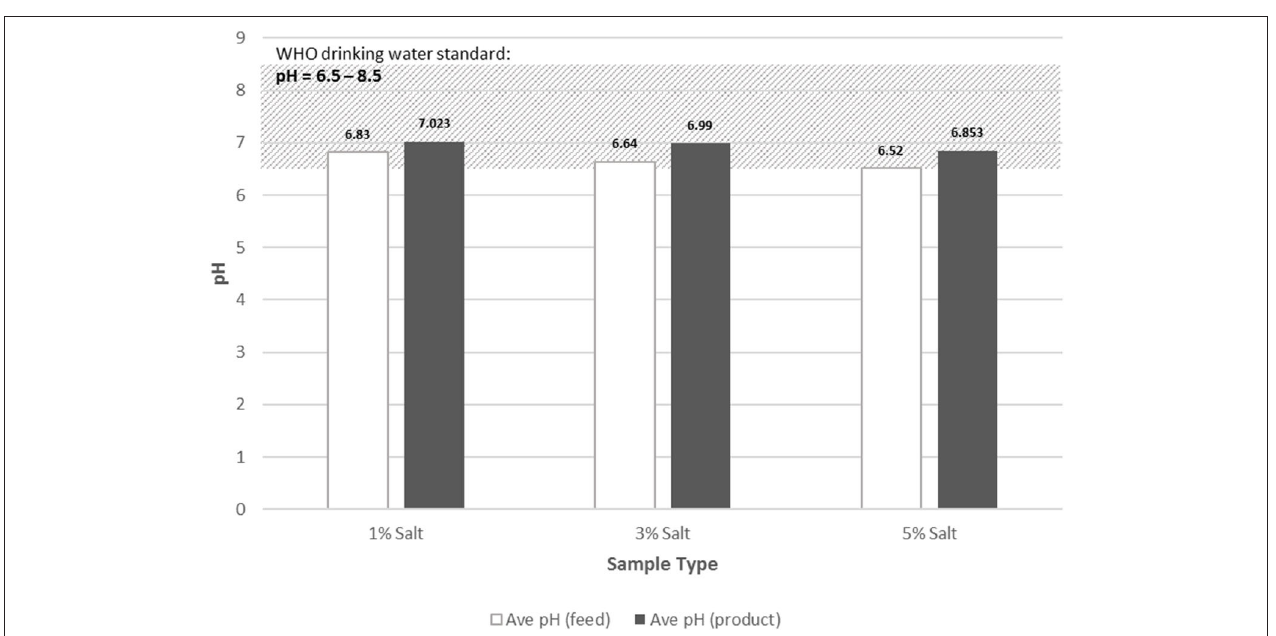
FIGURE 10 | Values of pH of feed and product